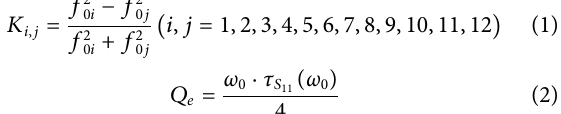
FIGURE 2 | Field pattern of TE 102 -mode in single SIW